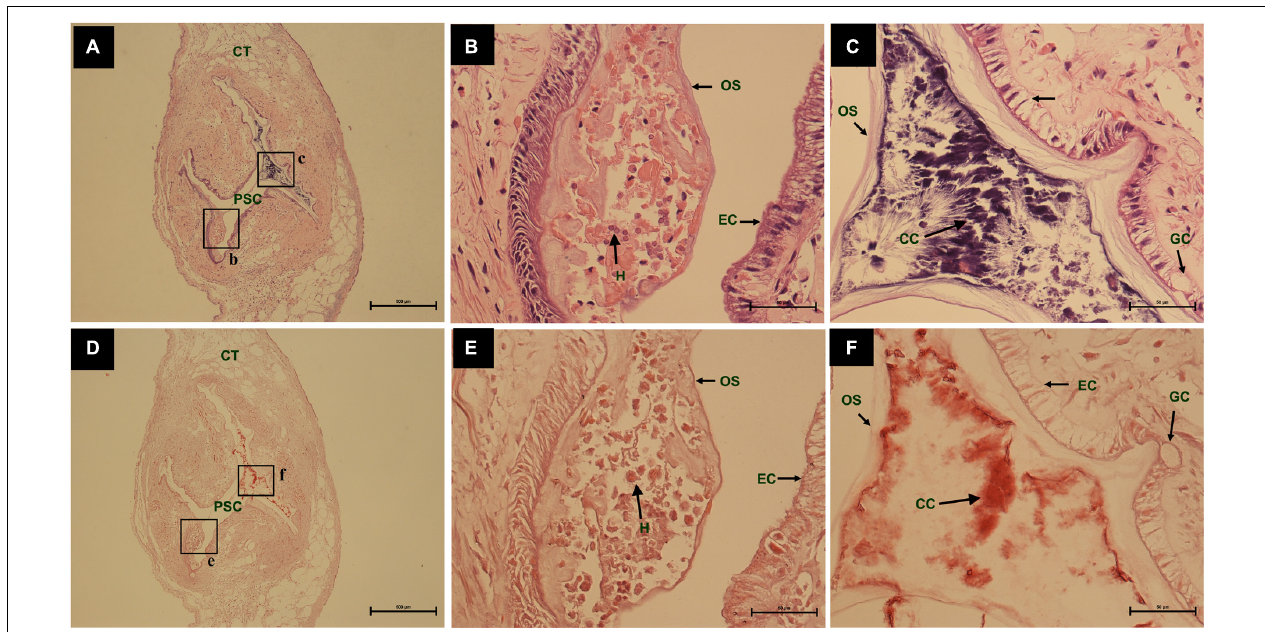
FIGURE 3 | The comparing of histology from same pearl sac on day 12 after grafting by different stain methods. (A,D) are a low power views stained by Haematoxylin-Eosin and Alizarin Red S, respectively. The black boxes indicate the areas shown at higher magnification. (B,C) are the high magnification views of partial area of pearl sac in panels (A) . (E,F) are the high magnification views of partial area of pearl sac in panel (C) . The abbreviations indicate S, saibo, PSC, pearl sac cavity, H, hemocyte, CT, connective tissue, EC, epithelial cell on pearl sac, GC, gland cell on pearl sac, OS, organic substrate, CC, CaCO 3 crystals. Scale bars are 500 µ m in panels (A,D) , 100 µ m in panels (B , C,E,F) .